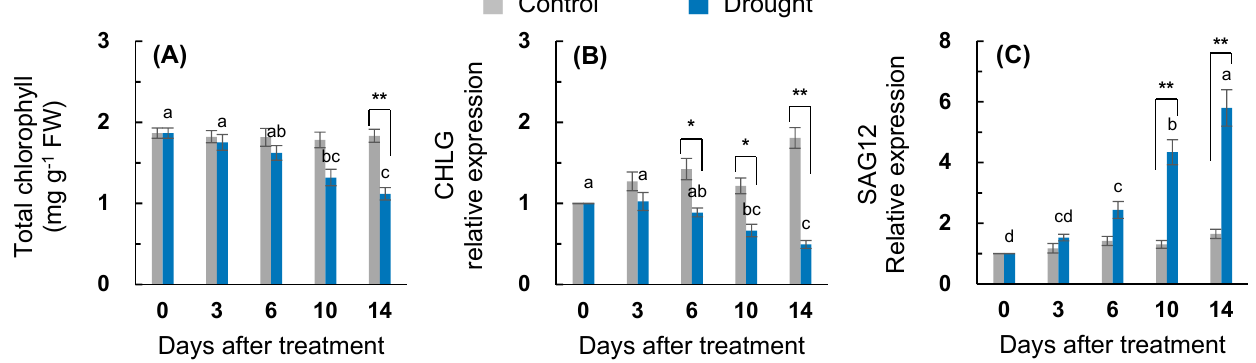
Values are means of three replicates with three plants each. Values in a vertical column or a horizontal row followed by different letters are significantly different at p < 0.05, according to Duncan’s multiple range test.